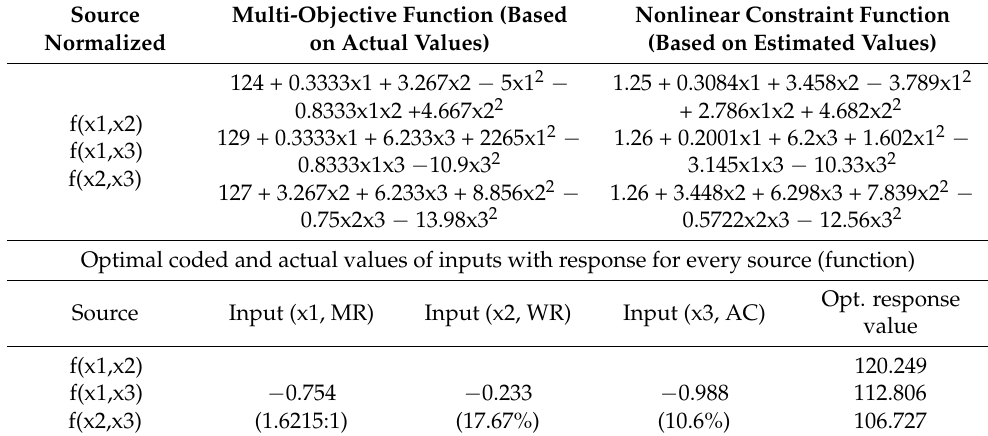
Table 5. The multi-objective and nonlinear constraints functions of the interactive effects of x1x2, x1x3, and x2x3 used to optimize the response being studied using the GA approach. Source Multi-Objective Function (Based Nonlinear Constraint Function Normalized on Actual Values) (Based on Estimated Values)